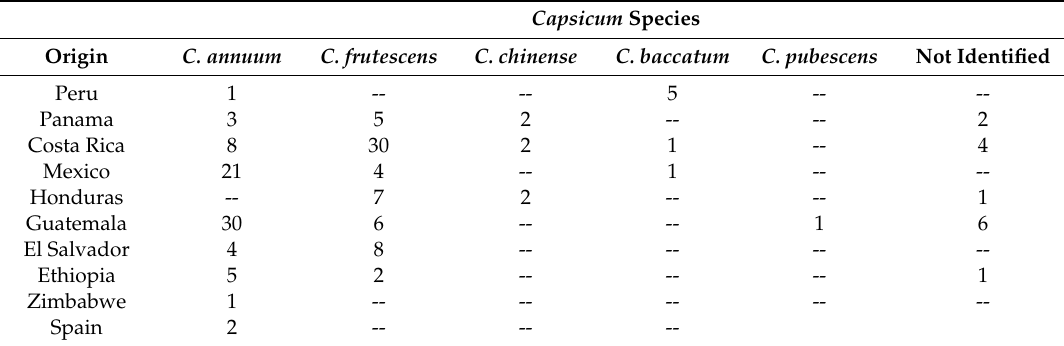
Table 1. Origin and number of accessions of each of the species of Capsicum